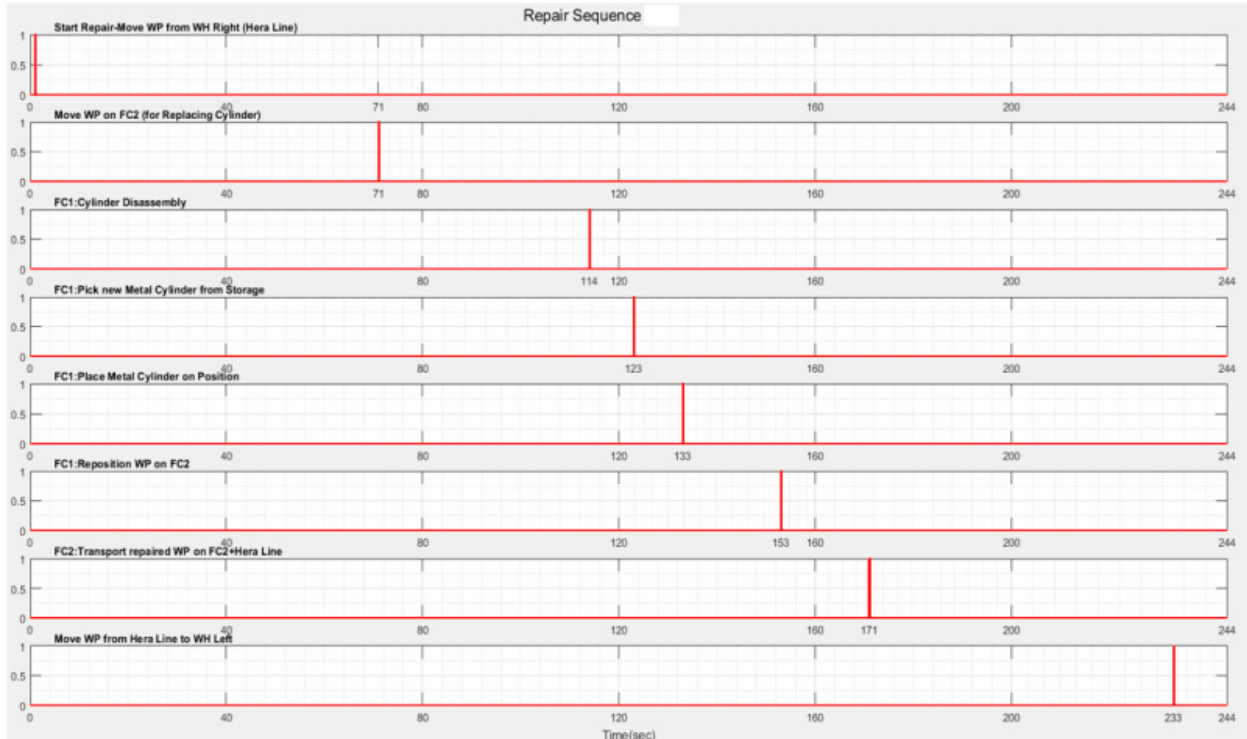
Figure 22. Real-time monitoring signals corresponding to repair operations of WP2.